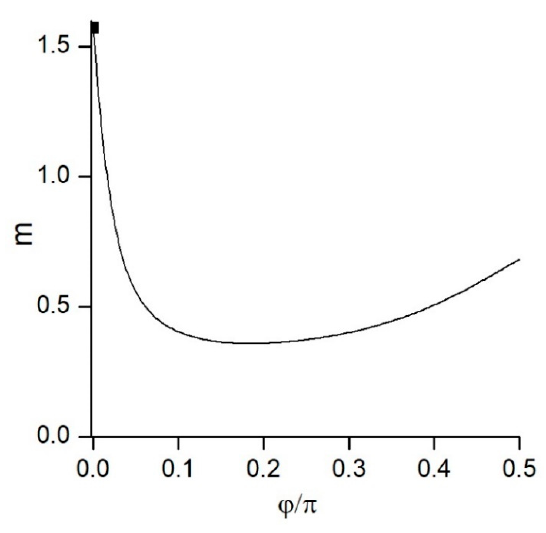
Figure 5. Coefficient of added mass for a circular arc impacting a cylindrical cavity vs the angle of the arc. The value m = π /2 corresponding to a flat plate, ϕ = 0, is shown by a solid